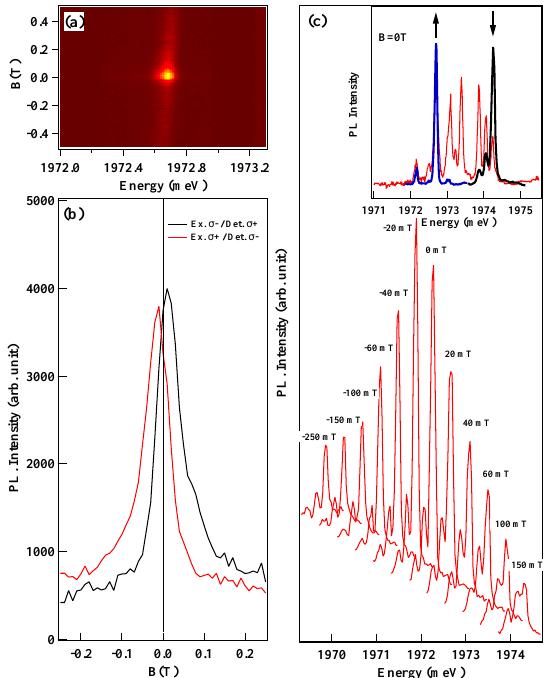
Figure 12: Longitudinal magnetic field dependence of the intensity of the resonant PL in a strain-free Mn-doped QD for crossed circular excitation and detection on the high and low energy lines, respec- tively. (a) Intensity map of the magnetic field dependence of the resonant PL. (b) Magnetic field dependence of the resonant PL in- tensity for σ − excitation / σ + detection (black) and σ + excitation / σ − detection (red). (c) PLE detected on the low energy line for a σ + excitation / σ − detection and different longitudinal magnetic fields (the curves are horizontally and vertically shifted for clarity). The inset presents the non-resonant PL (red), the resonant PL for an excitation on the high energy line (blue) and the PLE detected on the low energy line (black) at B = 0 T. Arrows indicate the excita- tion/detection configuration for the resonant-PL experiments.